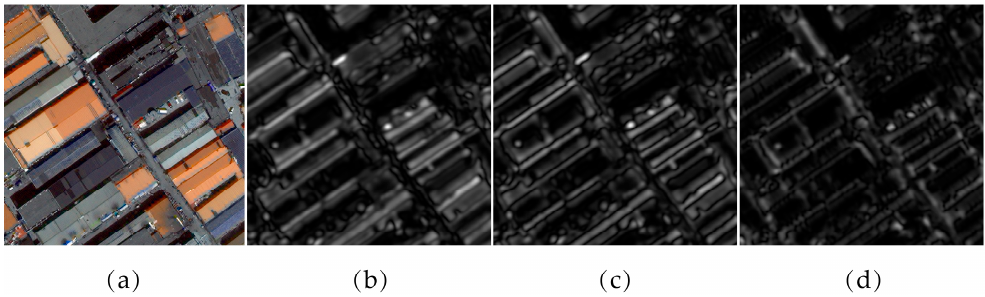
Figure 3. ( a ) The original sample image; ( b ) the response image with v = 2, u = 1; ( c ) the response image with v = 2, u = 1.5; and ( d ) the response image with v = 1, u = 1.5.